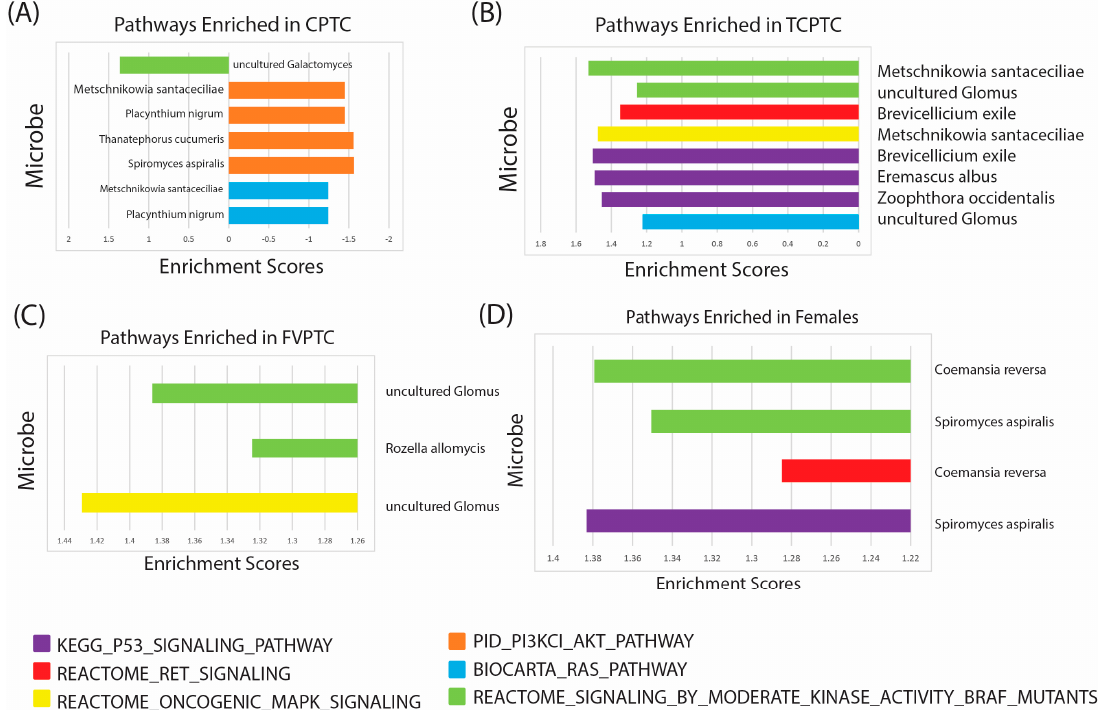
Figure 5. Enriched oncogenic signatures associated with dysregulated microbes in PTC and gender cohorts. Gene set enrichment analysis (GSEA) was conducted to identify unique oncogenic PTC signatures associated with dysregulated microbes pertinent to clinical variables ( p < 0.05 and false discovery rates (FDRs) < 0.25). ( A ) Bar plots visualizing enriched pathways associated with fungal microbe species in CPTC patients. A positive enrichment score indicates pathway enrichment in CPTC patients. ( B ) Bar plots visualizing enriched pathways associated with fungal microbe species in TCPTC patients ( C ) Bar plots visualizing enriched pathways associated with fungal microbe species in FVPTC patients ( D ) Bar plots visualizing enriched pathways associated with fungal microbe species in female patients. No significantly enriched pathways were observed in male patients.